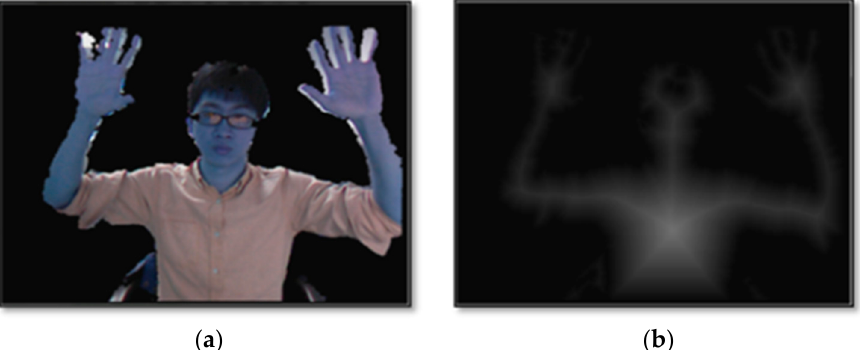
Figure 4. The distance transform process to highlight the outline of a skeleton frame: ( a ) before distance transform and ( b ) after distance transform.